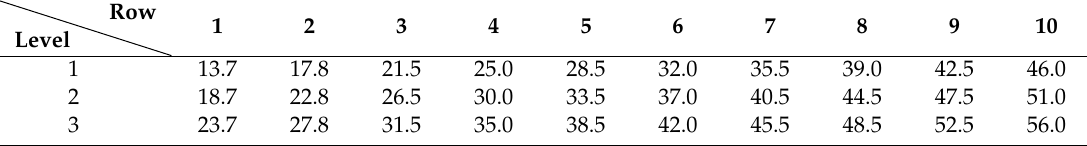
Table 2. Storage location operating time.